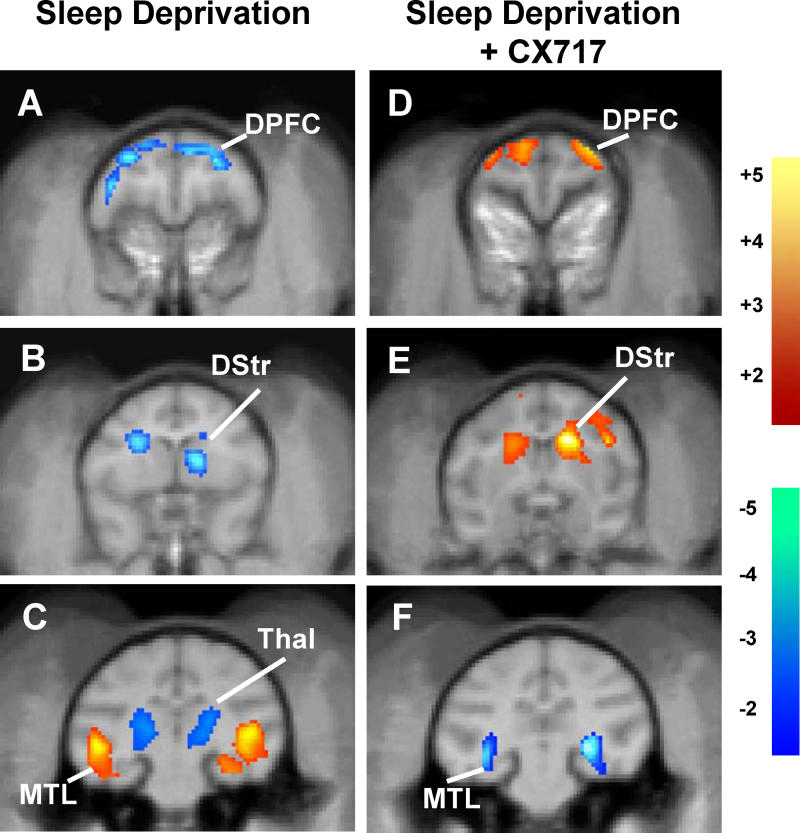
SPM Maps of Brain Regions Showing Changes in Regional CMRglc During Performance of DMS Task for Sleep Deprivation and Sleep Deprivation + CX717 Conditions(A–C) Maps are shown for the comparison of CMRglc during DMS performance in sleep deprivation to normal vehicle conditions (see Figure 7C–7E). Decreases (blue) are shown for DPFC (A), DStr (B), and thalamus (Thal; C). Increases in CMRglc (orange and yellow) are shown in C for MTL.(D–F) Maps shown for comparison of CMRglc during DMS performance in sleep deprivation + CX717 (0.8 mg/kg, IV) to the sleep deprivation condition. Increases in CMRglc were observed in DPFC (D) and DStr (E), whereas decreases were observed in MTL (F). Absence of labeled voxels for thalamus (Thal) in (F) indicates no change from sleep deprivation (C above) versus sleep deprivation + CX717 conditions.Regional changes are displayed on coronal sections of MR images of rhesus monkey brain at the level of the DPFC (A,D), DStr (B,E) and MTL (C,F). Statistical parametric maps were generated using SPM99 software. Colors indicate the location of clusters with a height threshold of p < 0.05 and spatial extent greater than 50 voxels. Color bars indicate t values (2–5; corresponding to p < 0.05 to p < 0.001, respectively) for significance of increase (red-yellow) or decrease (blue-green) in comparisons. Left and right hemispheres are on the left and right of images respectively.DOI: 10.1371/journal.pbio.0030299g008